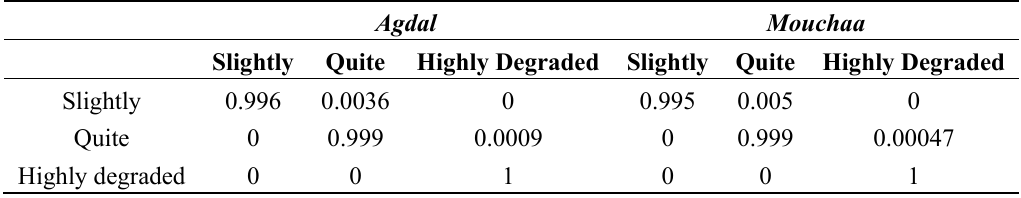
Table A1. Transition matrices between qualitative degradation levels for parcels managed as agdal or mouchaa . Degradation is faster in mouchaa than in agdal .